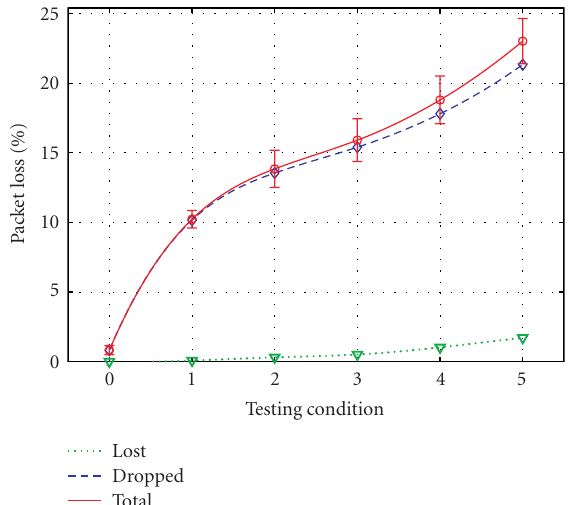
Figure 11: Impact of background tra ffi c on speech quality of speech sequences. Other detailed descriptions of Figure 7 apply appropri- ately.